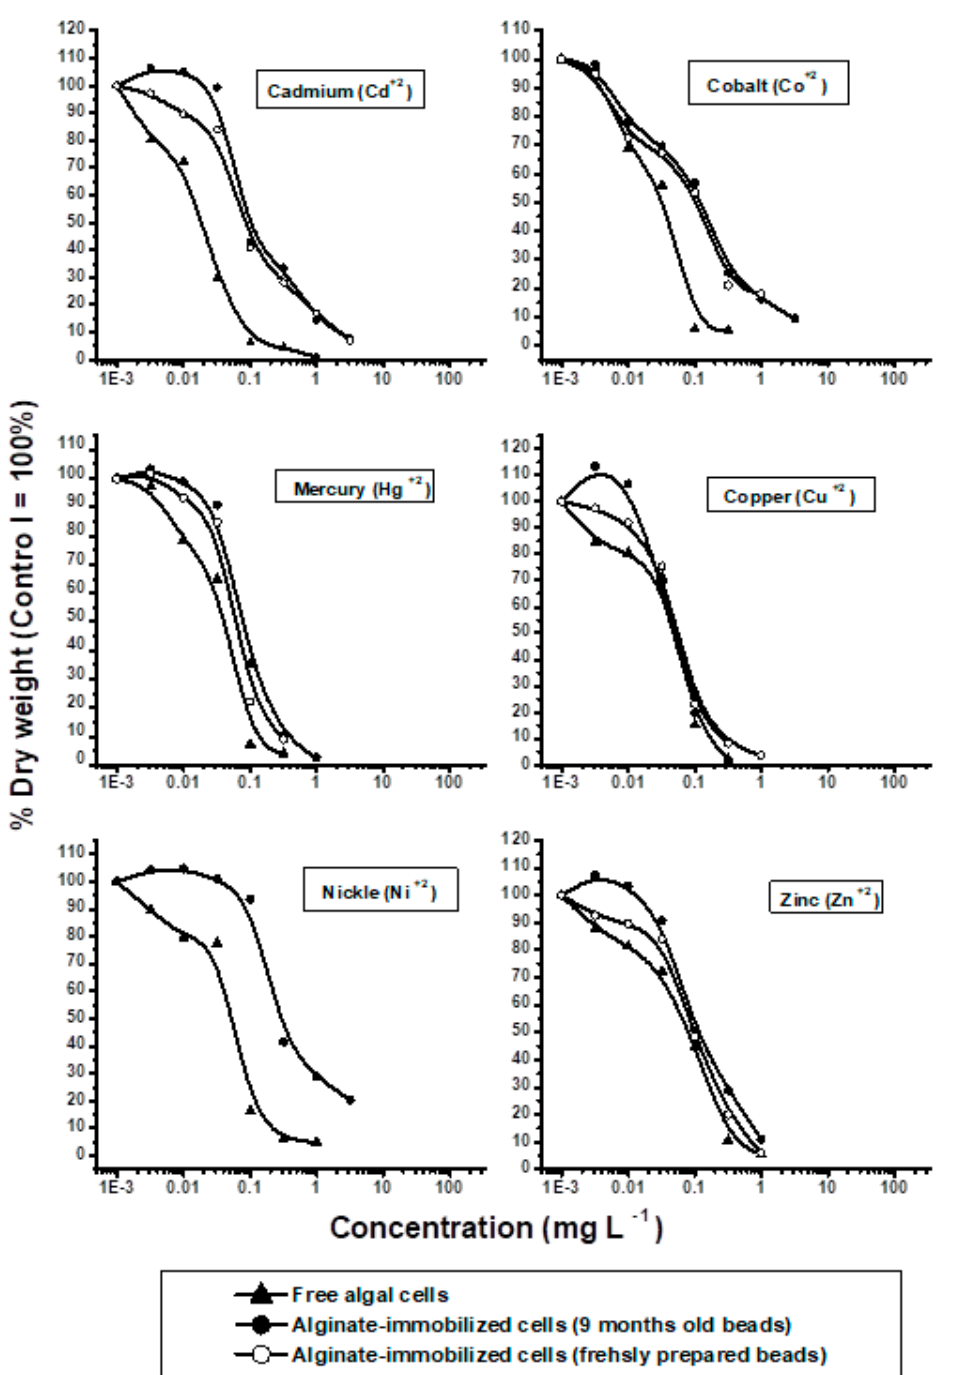
Figure 1. Effect of Cd, Co, Hg, Cu, Ni and Zn on growth of free and alginate- immobilized cells of Pseudokirchnerilla subcapitata .